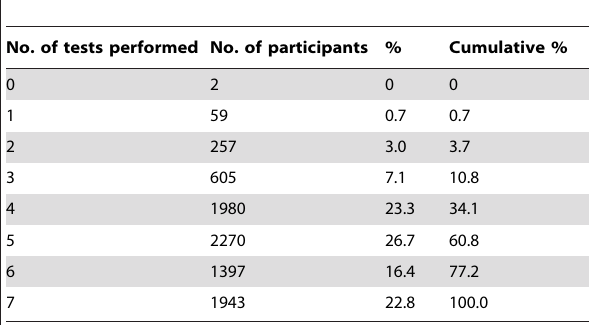
Table 6. Number of valid* tests performed on participants